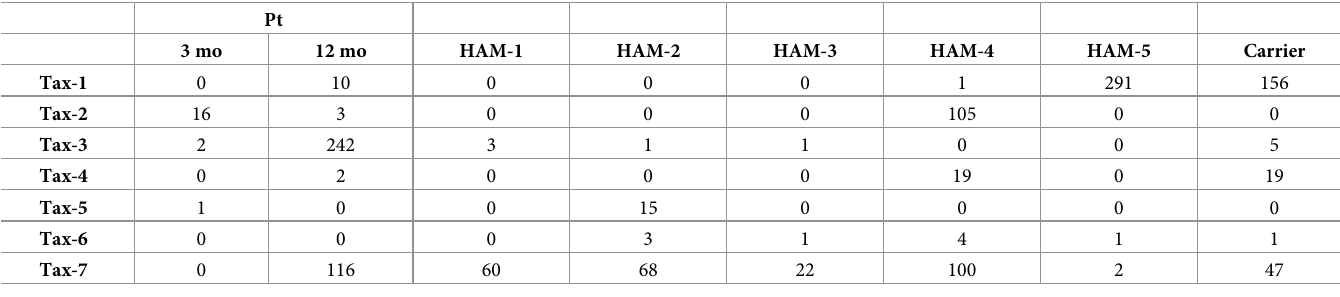
Table 1. HTLV-1 Tax specific IFN- γ responses in the live-liver transplanted patient, HAM/TSP patients and a HTLV-1 carrier.